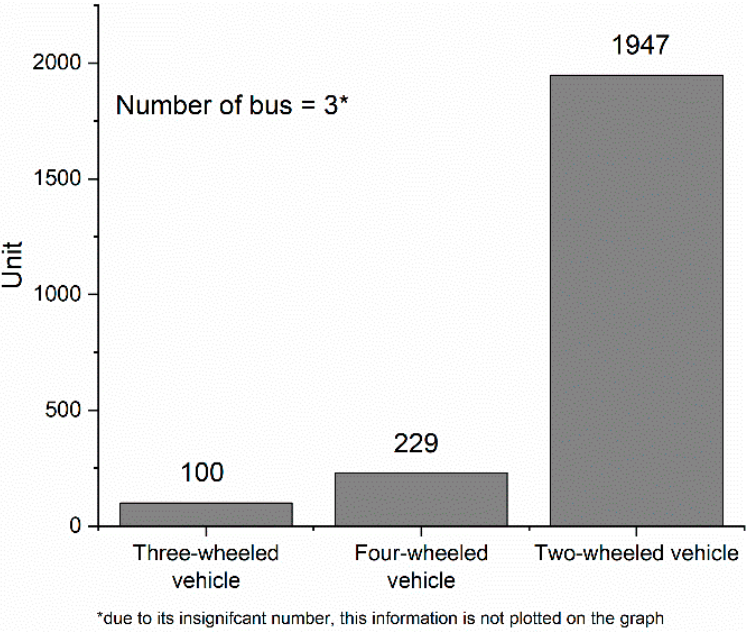
Figure 7. The number of EVs that passed the feasibility test in Indonesia (2020).